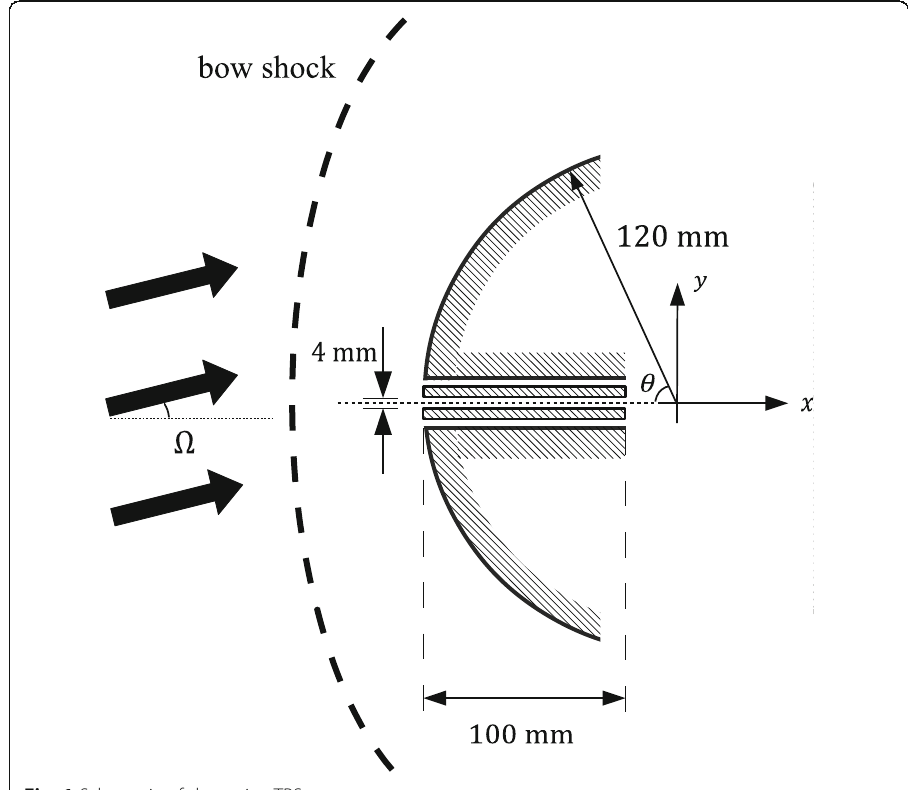
Fig. 1 Schematic of the active